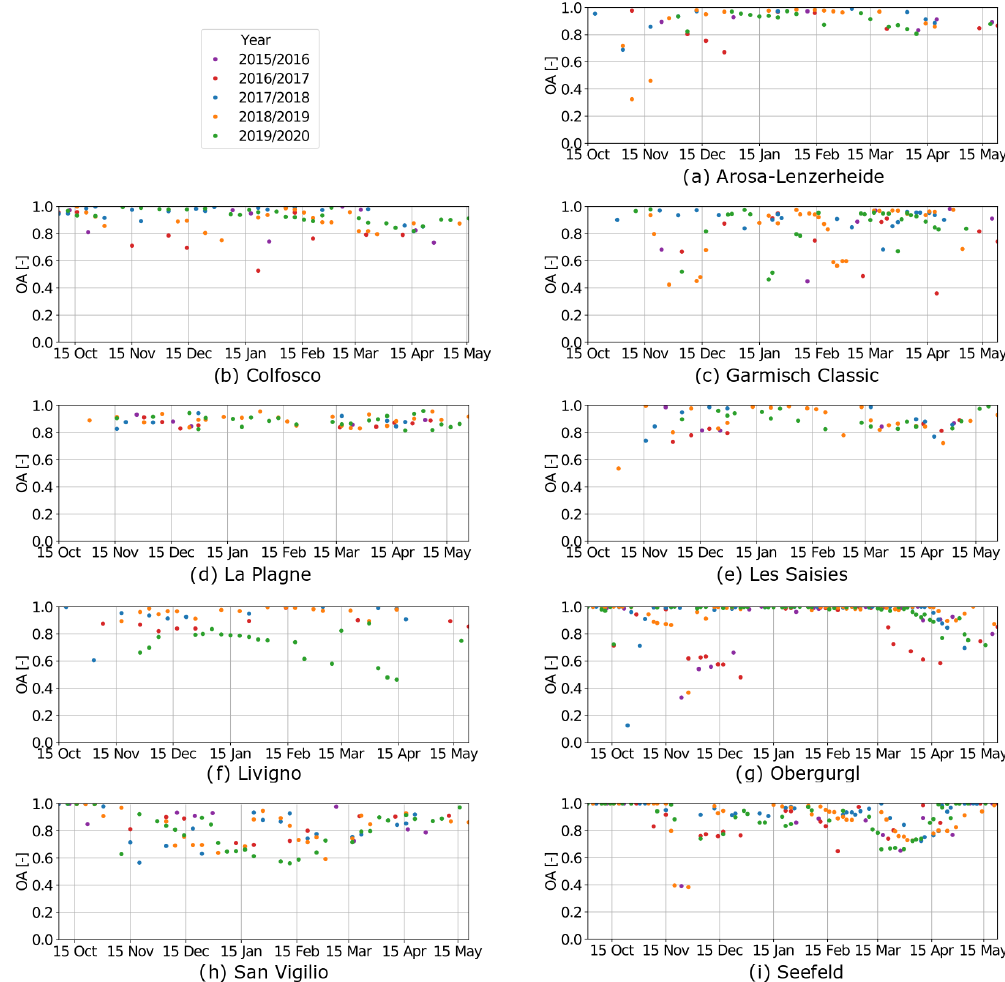
Figure A1. Overall agreement over time between simulation and S2 data for each ski resort for natural snow outside of the pistes. We considered images ranging from the winter season 2015/16 to the winter season 2019/20, except for Livigno, where simulations are not available for the first season 2015/16 due to gaps in the meteorological forcing